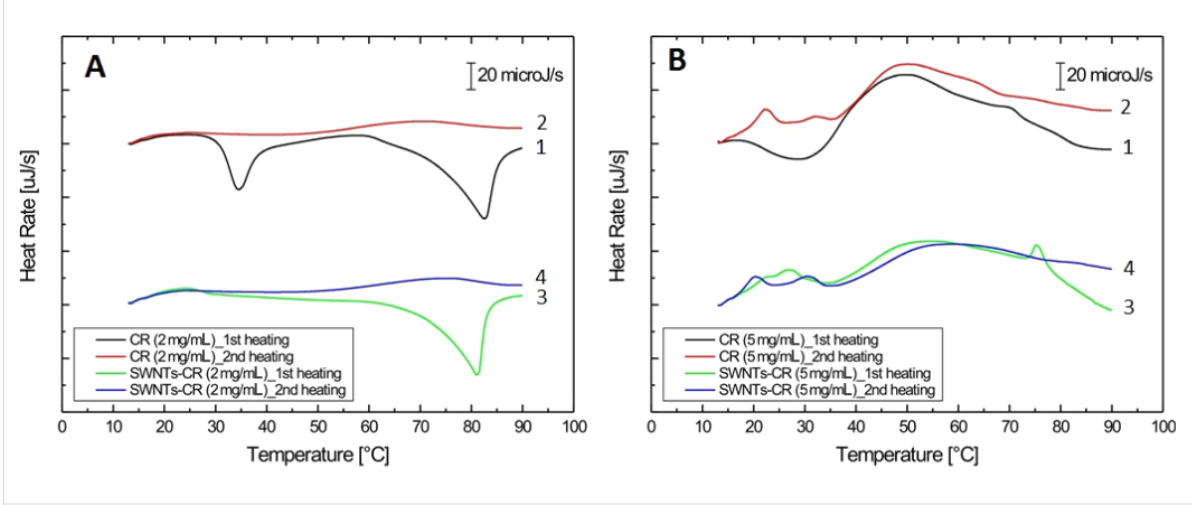
Figure 6: Calorimetric profiles obtained for free CR and CR bound to SWNTs: (A) 2 mg/mL CR; (B) 5 mg/mL CR. The first heating was always preceded by rapid cooling; second heating was preceded by controlled, slow cooling (1